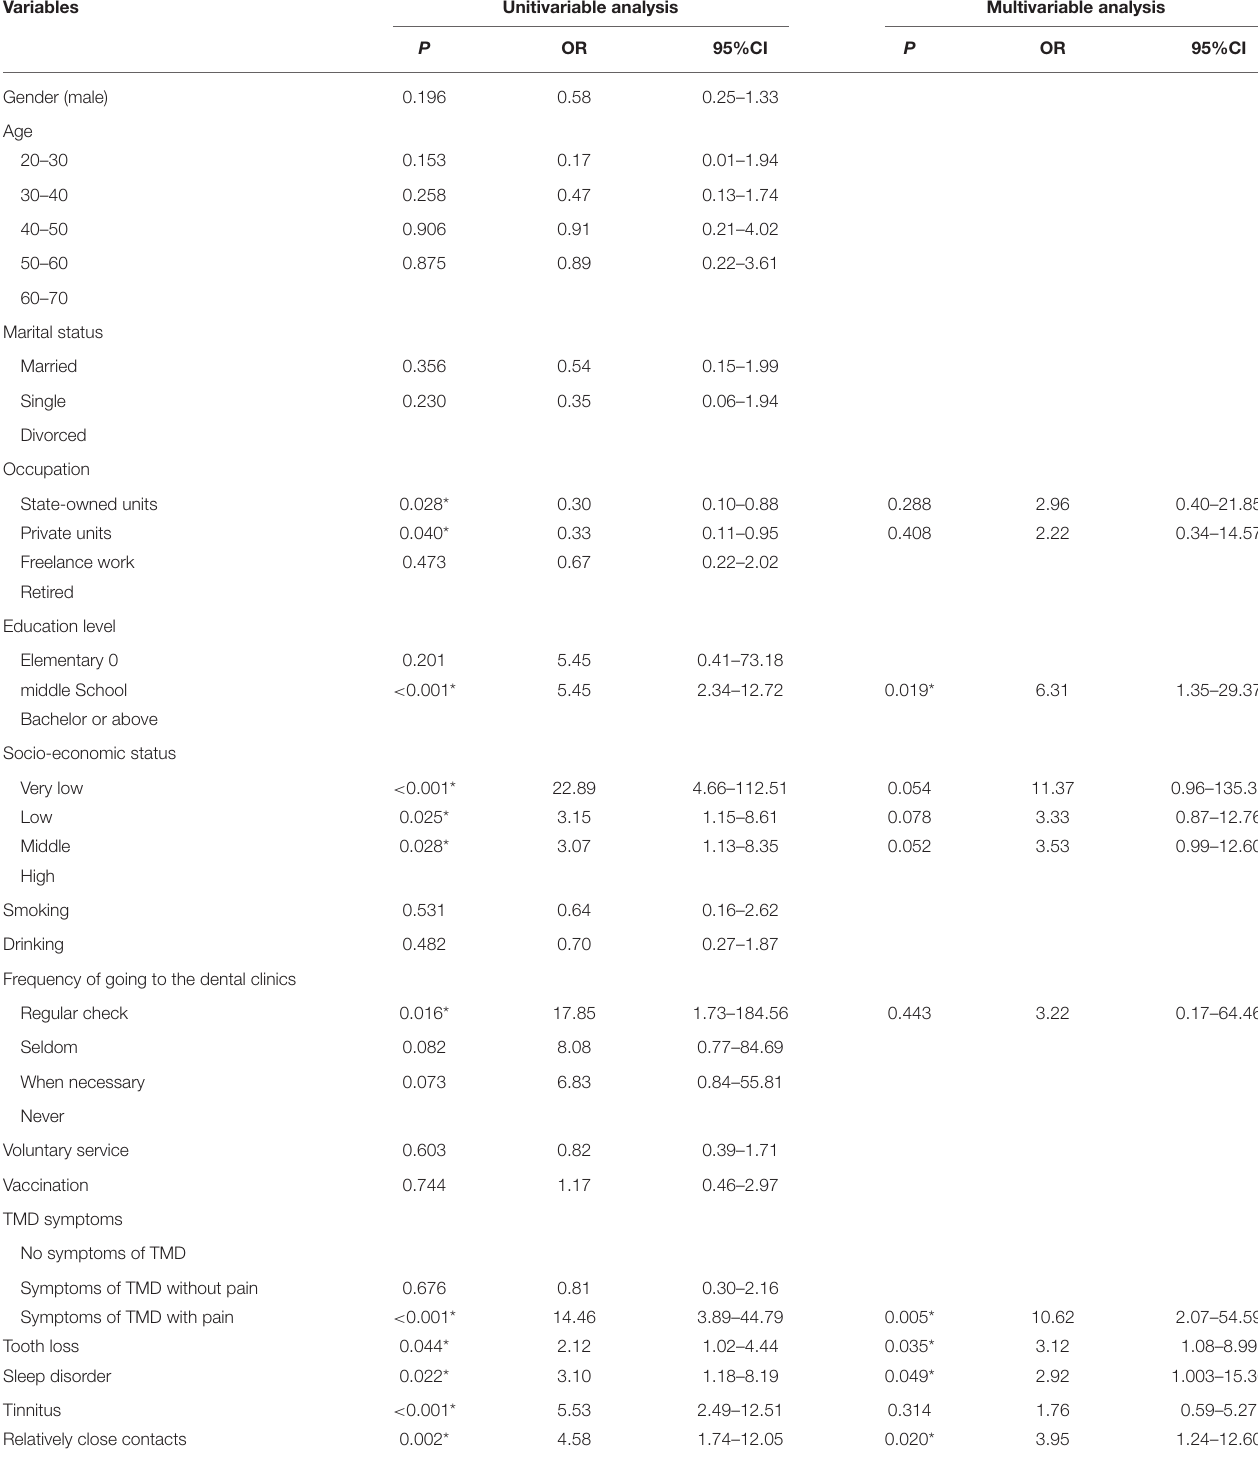
TABLE 3 | Factors associated with elevated